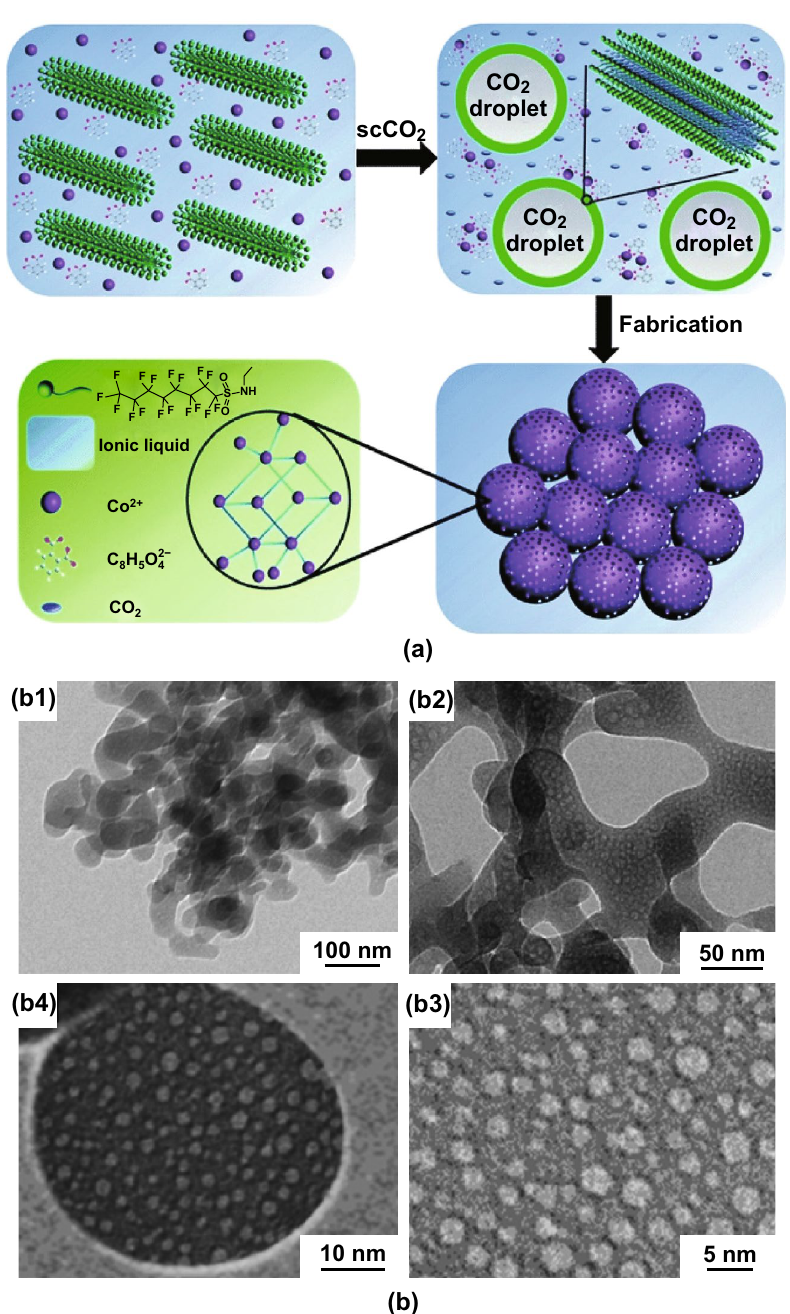
Fig. 17 a Schematic illustration for the formation of the mesoporous Co-MOF in an IL/SC CO 2 /surfactant emulsion system. b TEM images of the Co-MOF synthesised in an IL/SC CO 2 /surfactant emulsion system at 16 MPa and 80 °C for 48 h. Reprinted with permission from Ref.